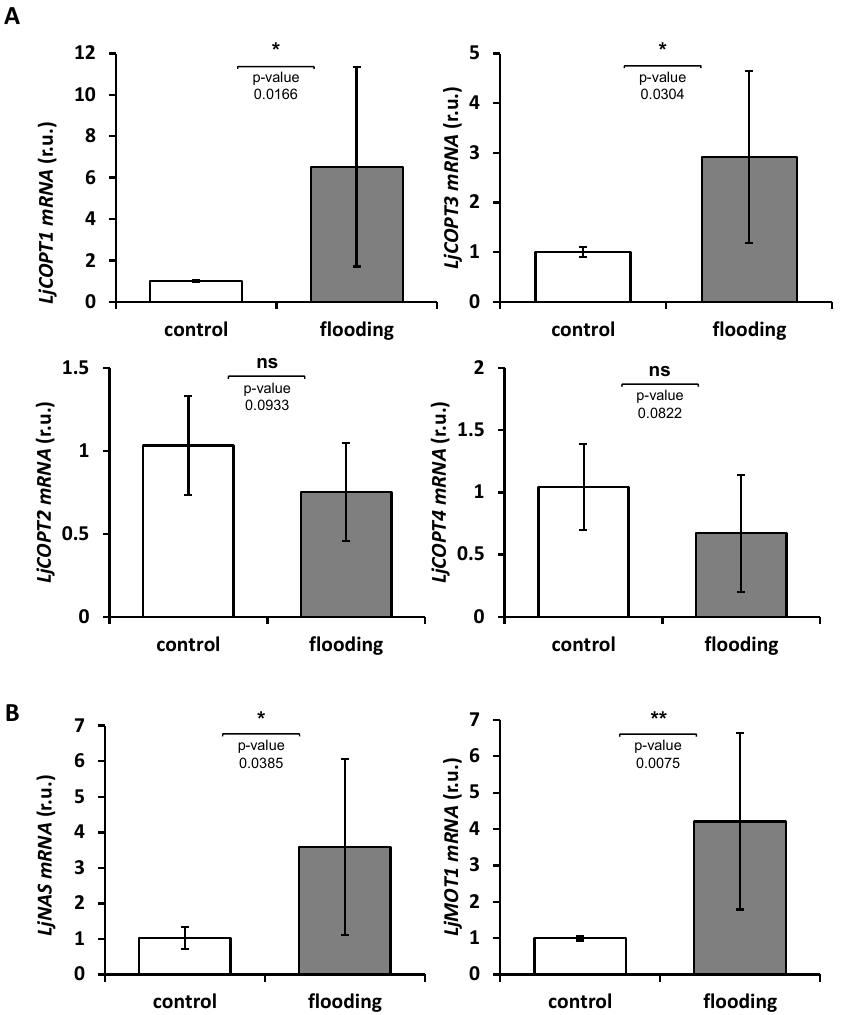
Figure 6. Gene expression of metal homeostasis related genes in Lotus japonicus . Gene expression of LjCOPTs ( A ), Lotus japonicus Nicotianamine Synthase ( LjNAS ) and L. japonicus Molybdenum transporter LjMOT1 ( B ) were analyzed by RT-qPCR from shoots and normalized to the transcript levels of EF . The control condition was used as a reference. Plants were grown under partial submergence as described in Material and Methods. Values are means ± SD of three biological replicates. Between treatments for each genotypes, one asterisk ( P < 0.05) and two asterisks ( P < 0.01) over the bars mark a significant difference; ns indicate no significant difference ( P > 0.05).